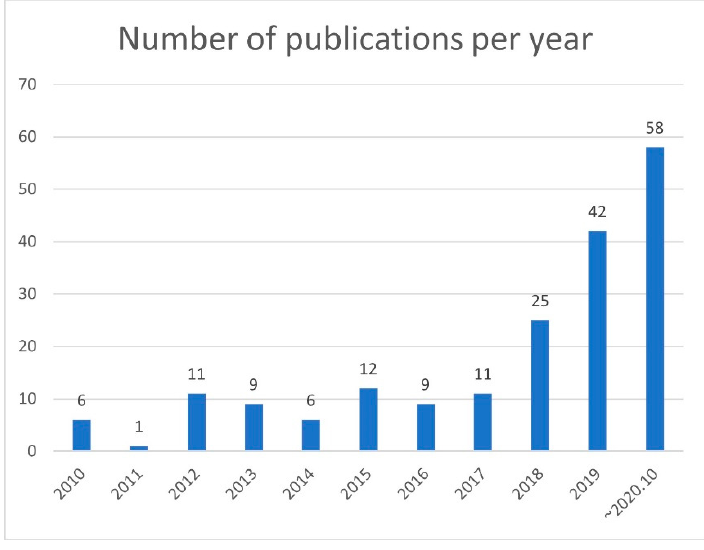
Figure 3. Number of publications per year.